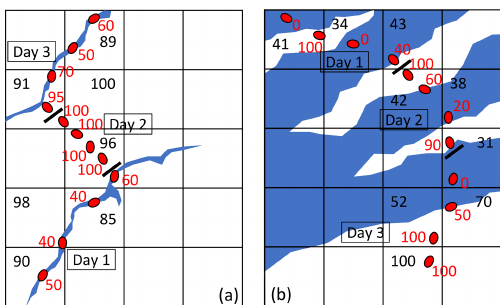
Figure 17. Illustration of the representativity of ship-based obser- vations (red ellipses and numbers) compared to gridded satellite ob- servations (black grid and numbers) for (a) close pack ice with leads and (b) an open sea-ice cover in the marginal ice zone. Size of el- lipses is in scale with the grid cell size of 25km by 25km. Short black bars denote transitions between days. See also Table